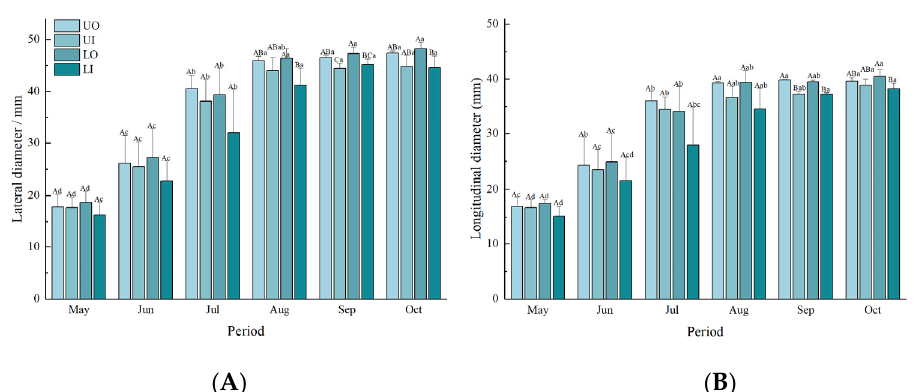
Figure 1. Variations of lateral diameter ( A ) and longitudinal diameter ( B ) of C. oleifera ‘Huaxin’. Note: Data are represented as the mean value ± standard deviation (SD; n = 6). Different uppercase and lowercase letters indicate significant differences ( p ≤ 0.05; Duncan’s multiple range tests) between locations and periods, respectively.